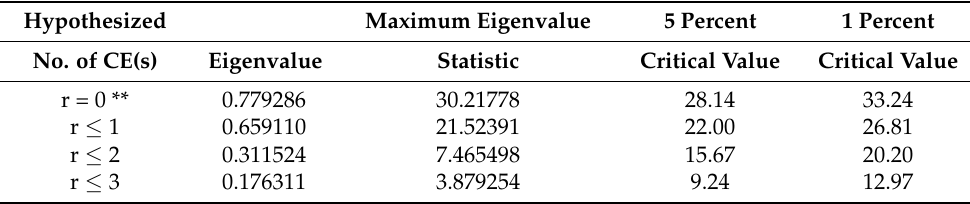
Table 3. Johansen cointegration technique results (Trace Statistics). Hypothesized Trace 5 Percent 1 Percent No. of CE(s) Eigenvalue Statistic Critical Value Critical Value r = 0 ** 0.779286 63.08644 53.12 60.16 r ≤ 1 0.659110 32.86866 34.91 41.07 r ≤ 2 0.311524 11.34475 19.96 24.60 r ≤ 3 0.176311 3.879254 9.24 12.97